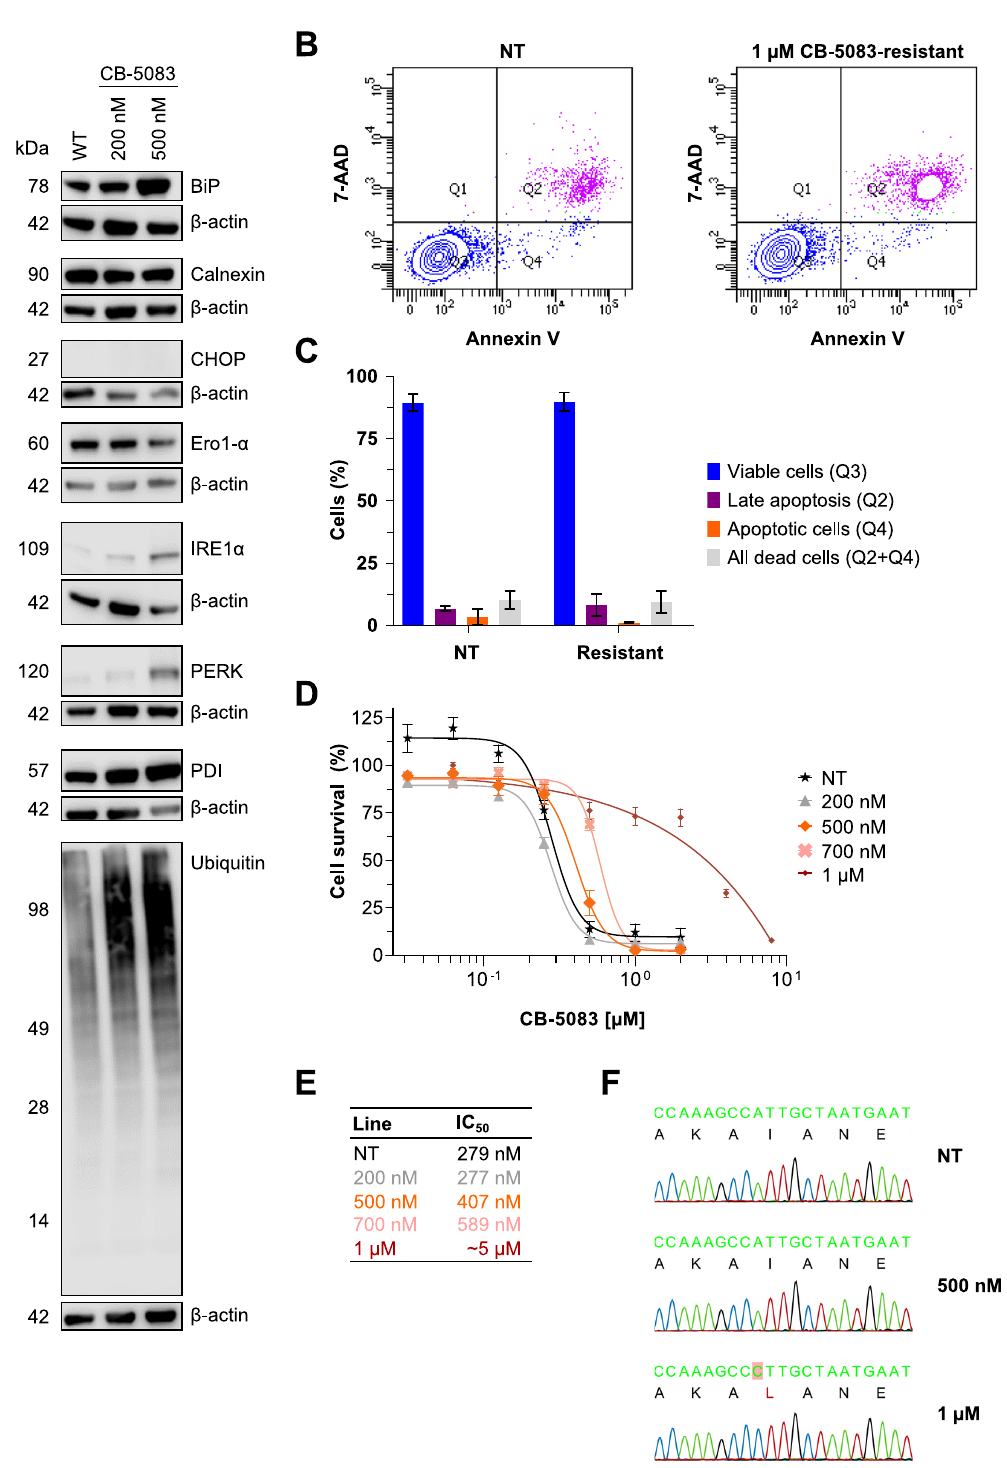
Fig 6. CB-5083-resistant MV4-11 cells exhibit features of permanent endoplasmic reticulum (ER) stress but no apoptosis. (A) Immunoblot showing induction of ER stress in inhibitor-resistant cells after a few months of continuous treatment with 200 and 500 nM CB-5083. (B and C) Flow cytometry analysis using Annexin V and 7-AAD staining showed decreased apoptosis in CB-5083-resistant cell lines. (D and E) IC 50 values for CB-5083 in the indicated cell lines upon withdrawal and re-treatment with CB-5083. (F) Analysis of the coding sequence of VCP identified a variant (c.1591C > A p.I531L) in the cell line treated with 1 μ M CB-5083.